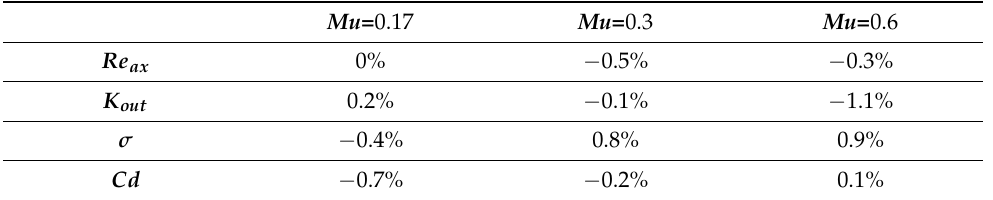
Table 3. Differences on dimensionless numbers between steady and unsteady solutions for OAS cases with c / R = 1.9 × 10 − 3 ; Π = 1.3; K in = 0; for different rotational speeds. Mu =